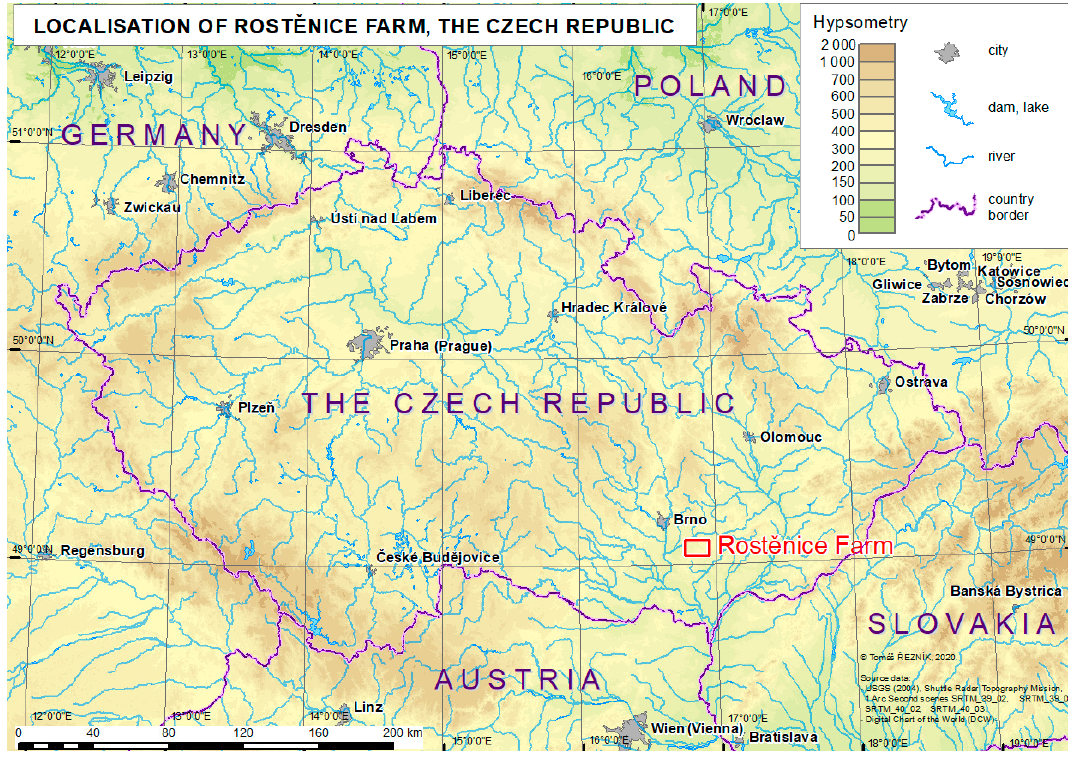
Figure 1. Geographical location of the Rost ě nice Farm.